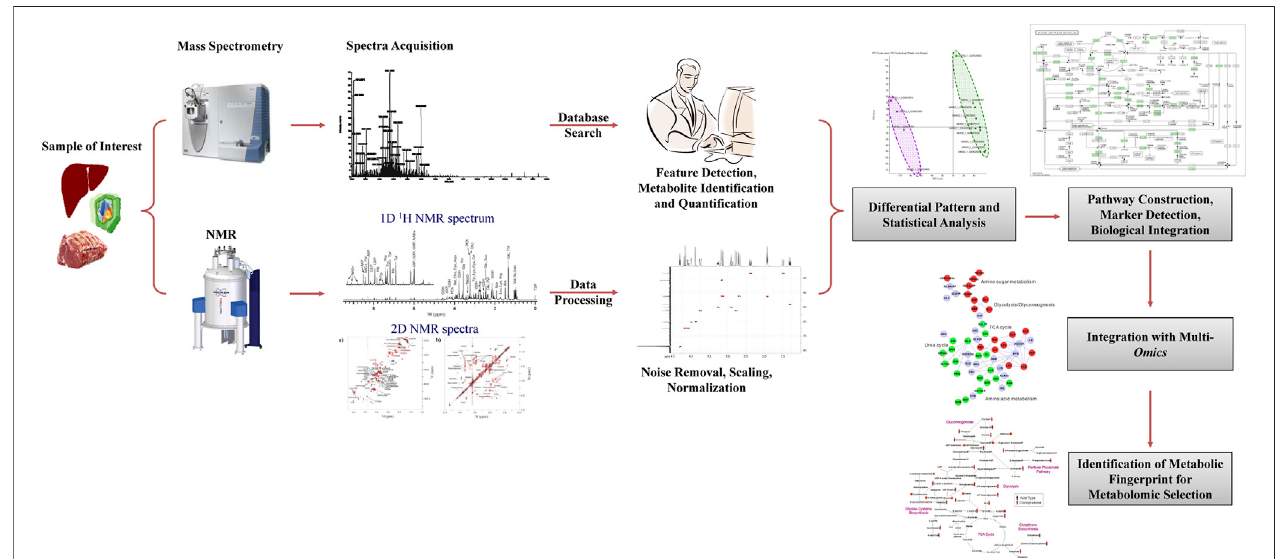
FIGURE 4 | Work fl ow for application of metabolomics on genetic selection of animals.